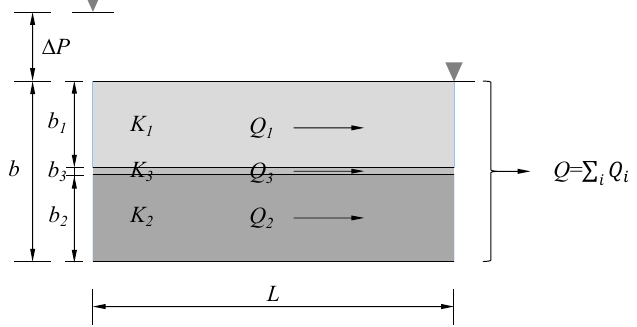
Figure 10. Schematic diagram of the flow of layered porous media along with the layer.